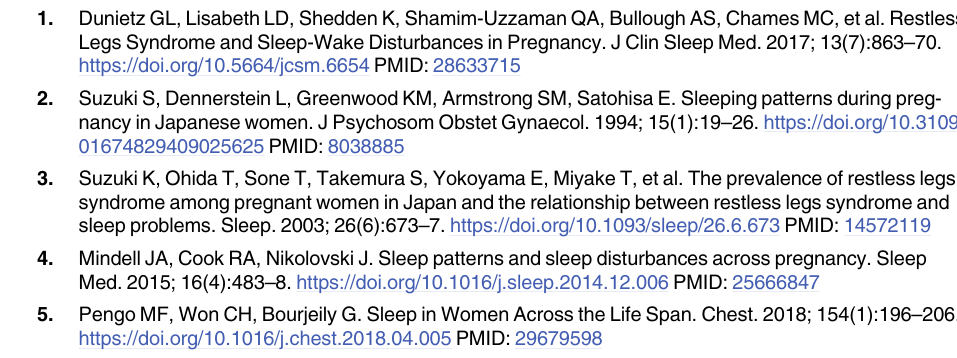
S1 Table. Relationship of maternal age, body mass index, hypertension, gestational diabe- tes mellitus and endometriosis with Perinatal